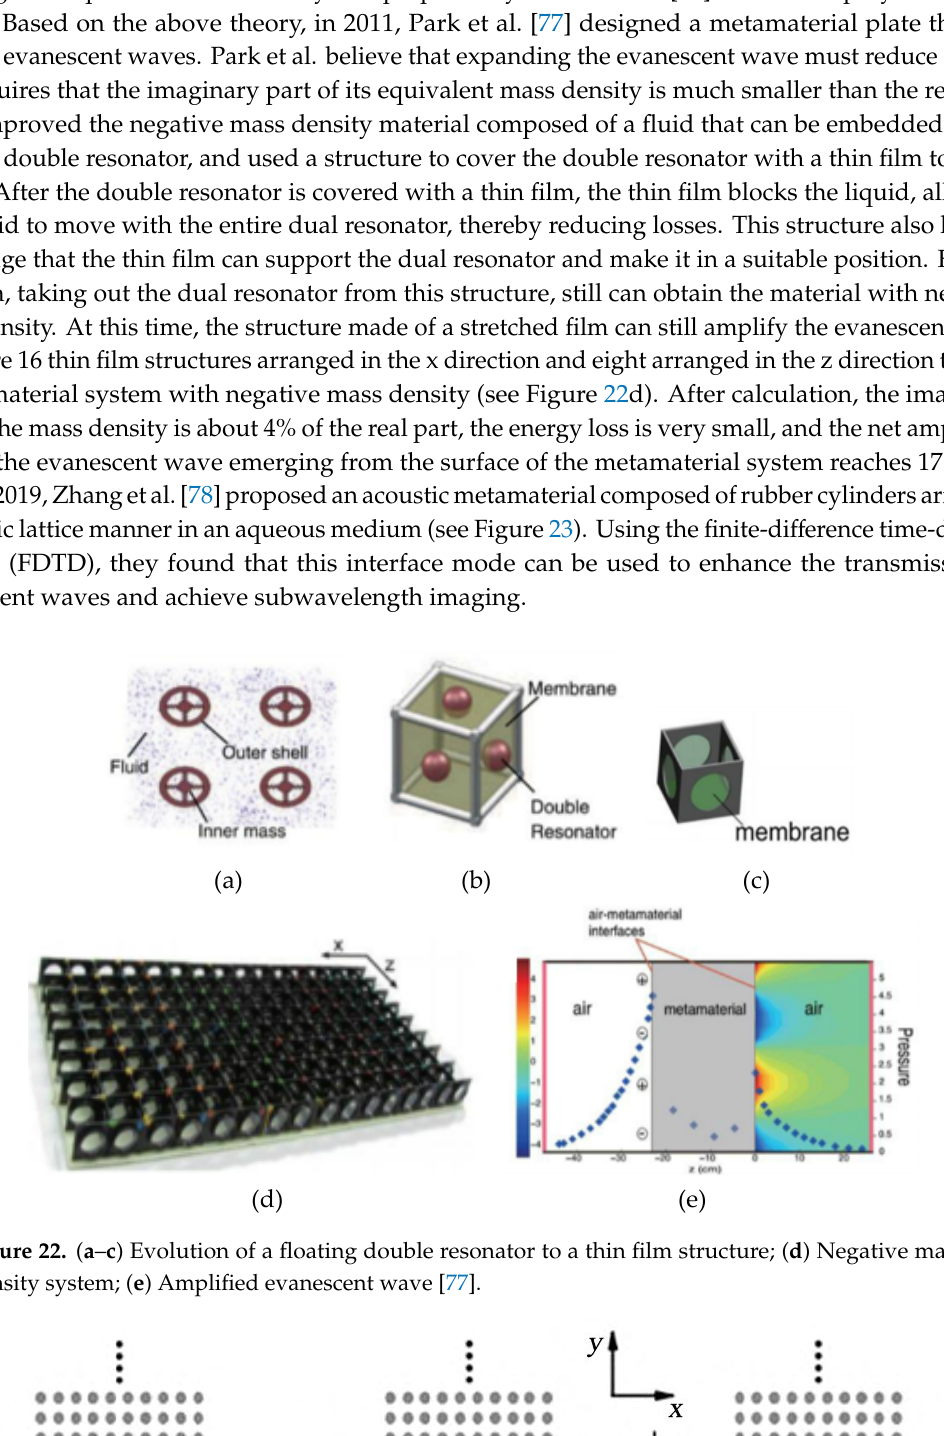
Figure 23. Supercell for calculations of interface modes [78].